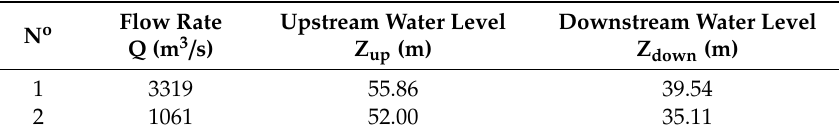
Table 1. Working